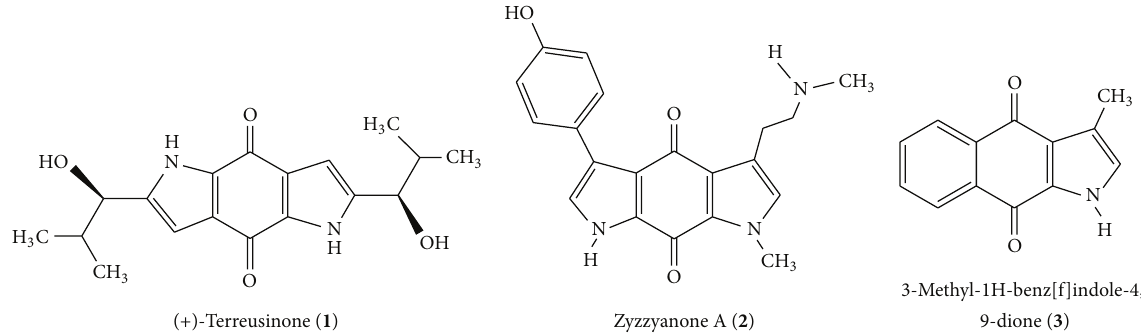
Figure 1: Selected natural products containing pyrroloquinone